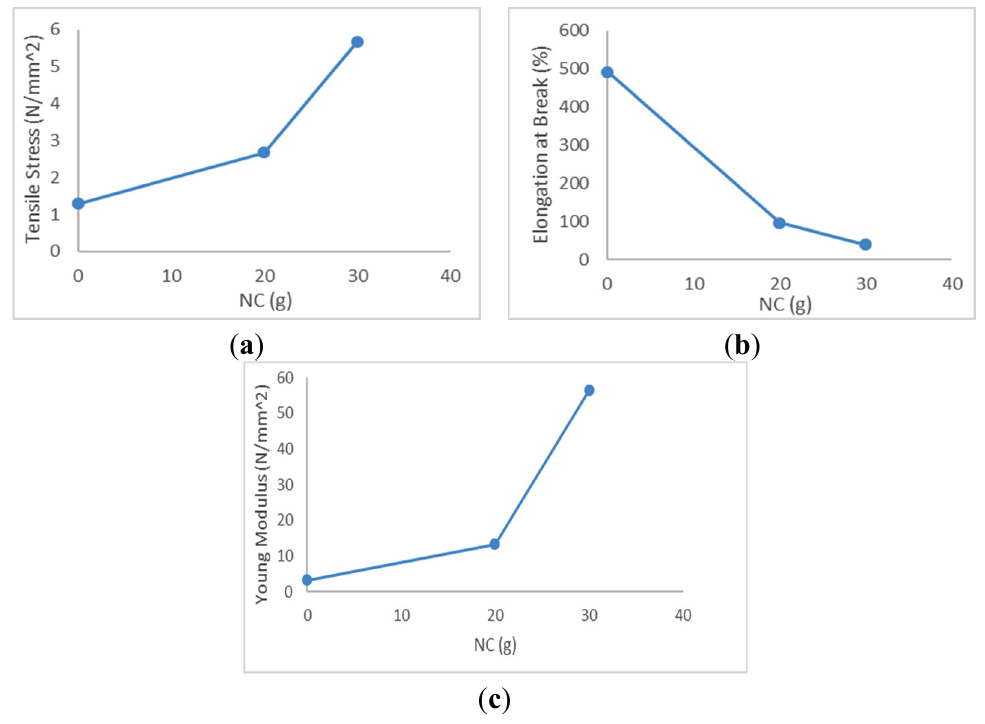
Figure 4. ( a ) Tensile stress, ( b ) elongation at break, and ( c ) young modulus for different